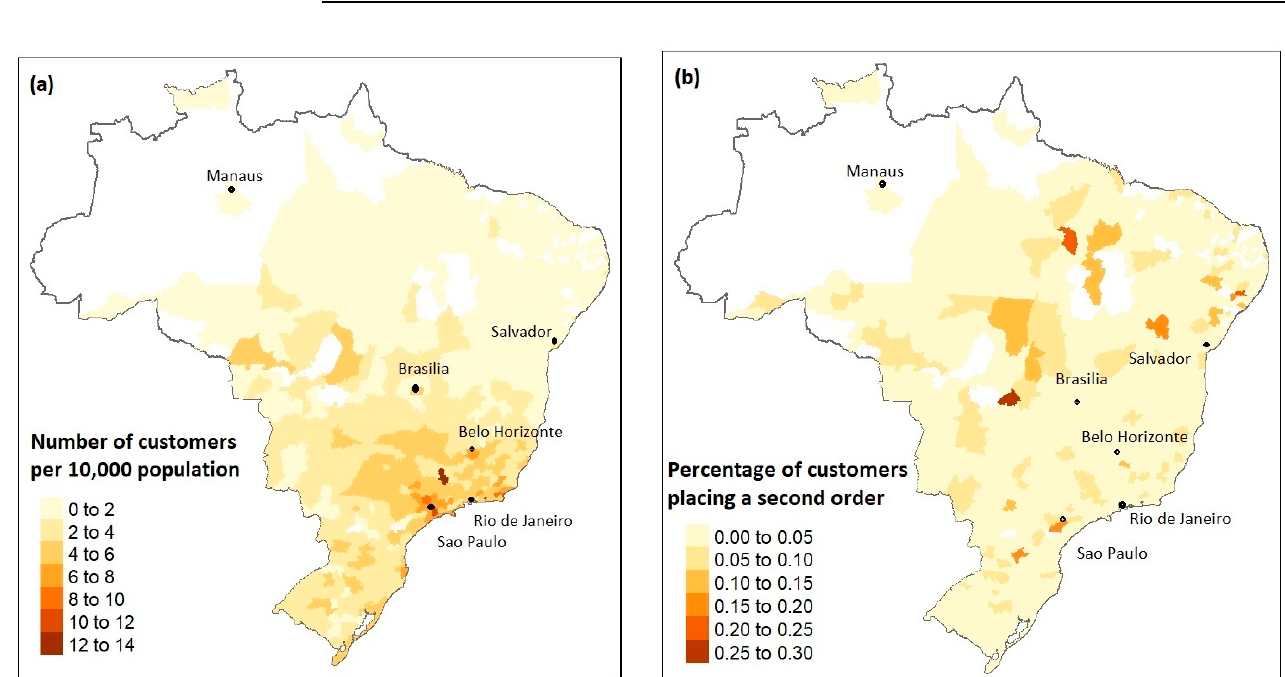
Figure 7. Map of Brazil’s population density.